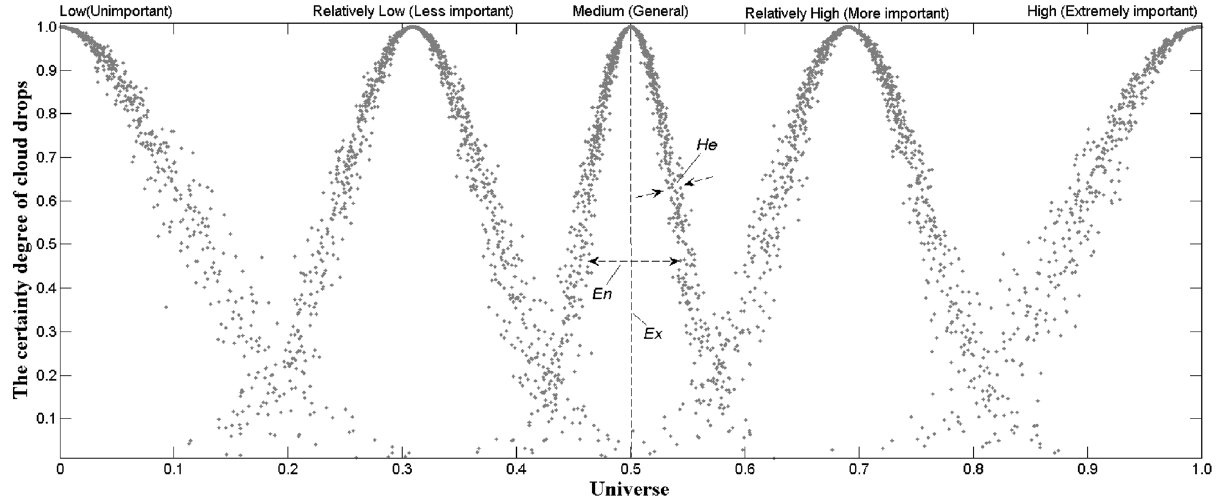
Figure 3. Cloud chart of evaluation criterion and weight.